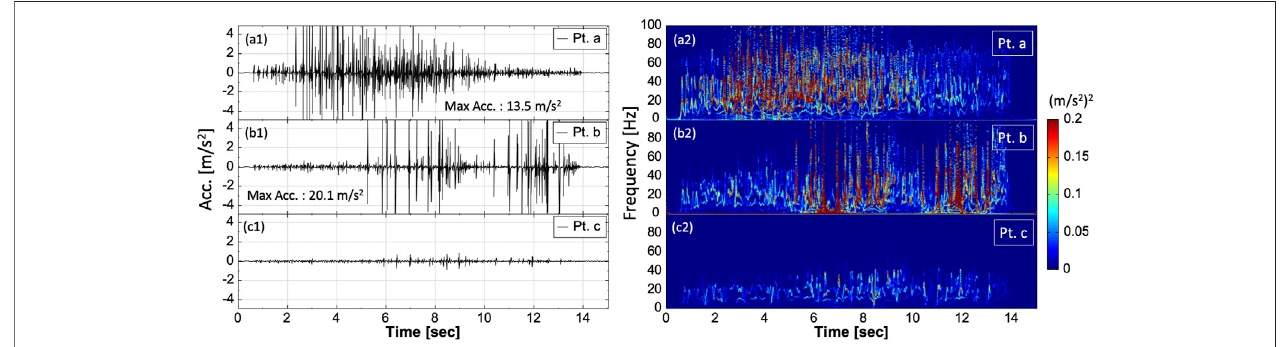
FIGURE 9 | Seismic signals and their corresponding time – frequency spectra with respect to the monitored points a, b, and c of the rock mixture fall simulation.